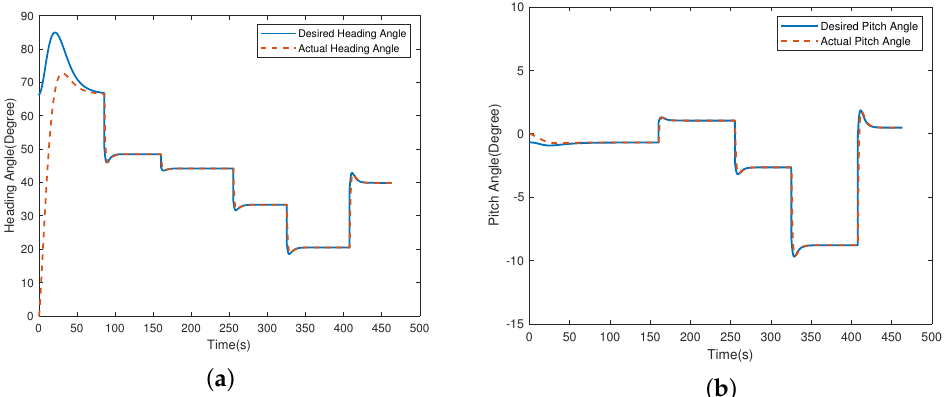
Figure 7. Tracking results of guidance angles. ( a ) Desired heading angle and actual heading angle. ( b ) Desired pitch angle and actual pitch